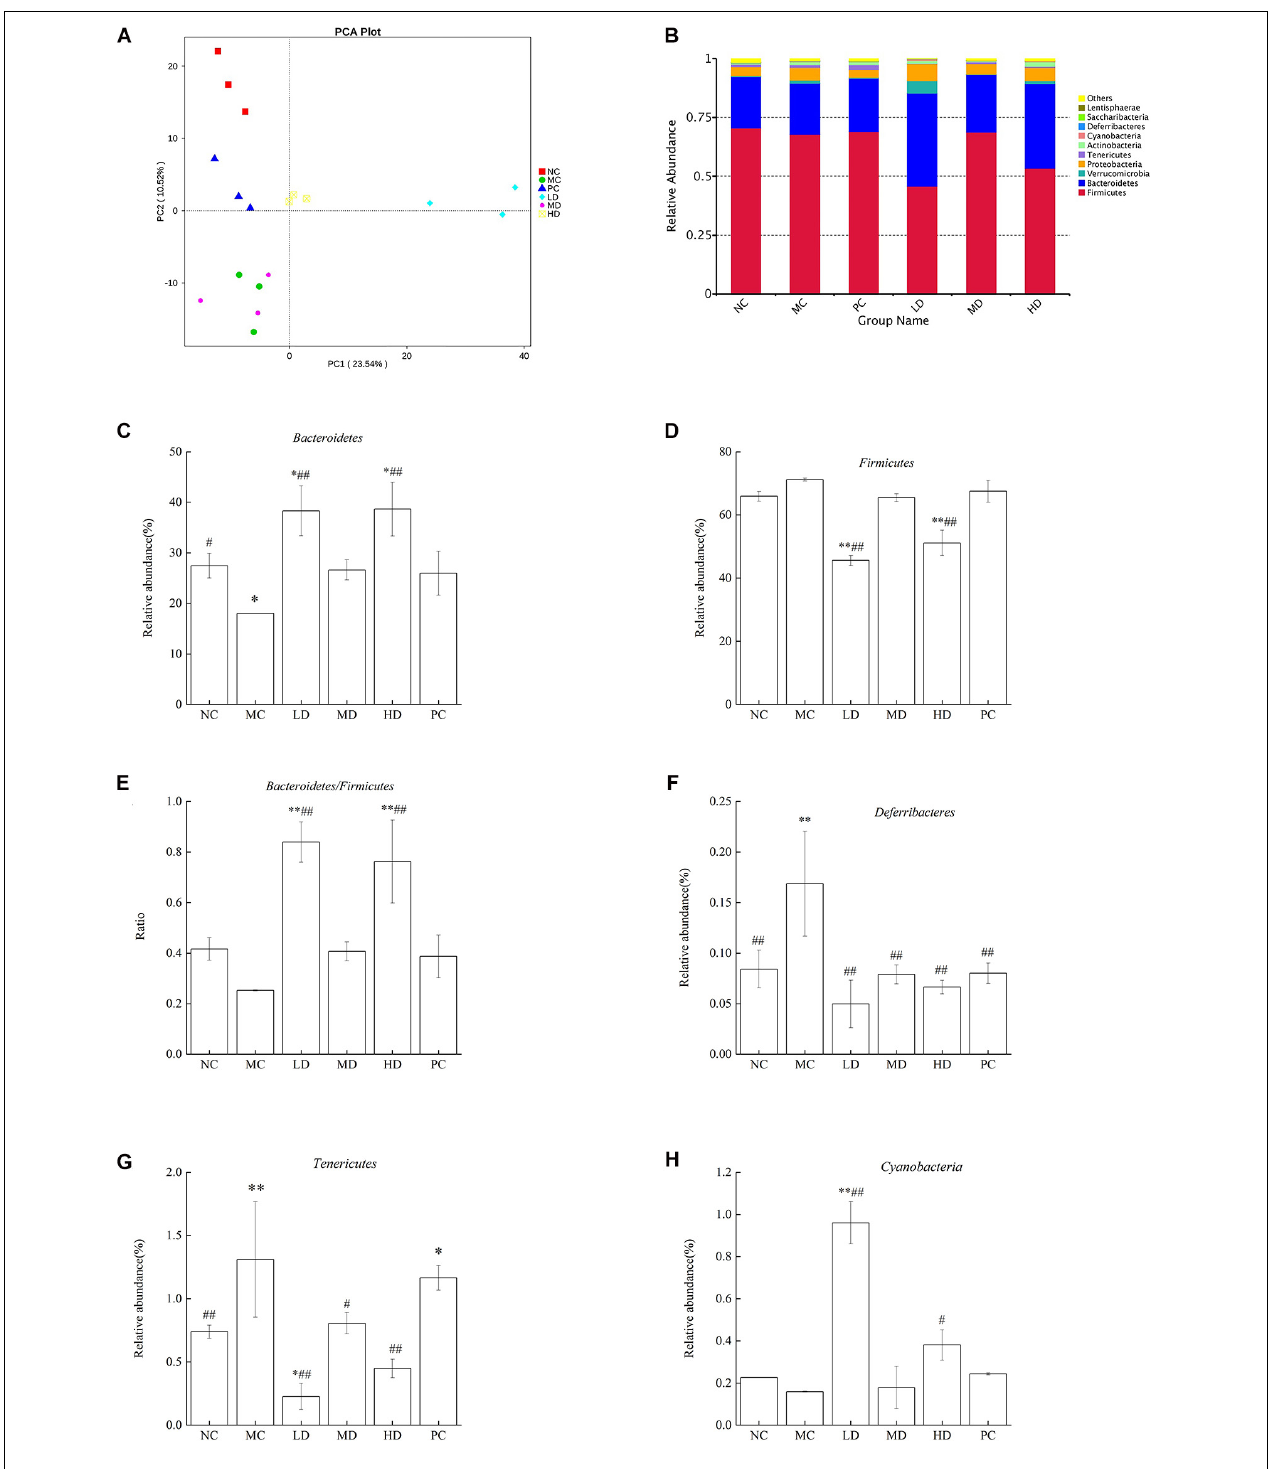
FIGURE 2 | BRS alters the composition based on OTUs and the relative abundance of gut microbiota at the phylum level. (A) Principal component analysis (PCA) of gut microbiota based on OTUs. The abscissa represents the first principal component, the ordinate represents the second principal component, and the percentage represents the contribution of the principal component to the sample difference. Each point in the figure represents a sample, and samples from the same group are represented in the same color. (B) Bacterial taxonomic profiling at the phylum level of gut microbiota. (C) Bacteroidetes , (D) Firmicutes , (E) Bacteroidetes/Firmicutes ratio, (F) Deferribacteres , (G) Tenericutes , and (H) Cyanobacteria . Differences were based on ANOVA analysis followed by LSD post hoc test and denoted in graph bars as follows: ∗ p < 0.05 and ∗∗ p < 0.01 compared with NC; # p < 0.05 and ## p < 0.01 compared with